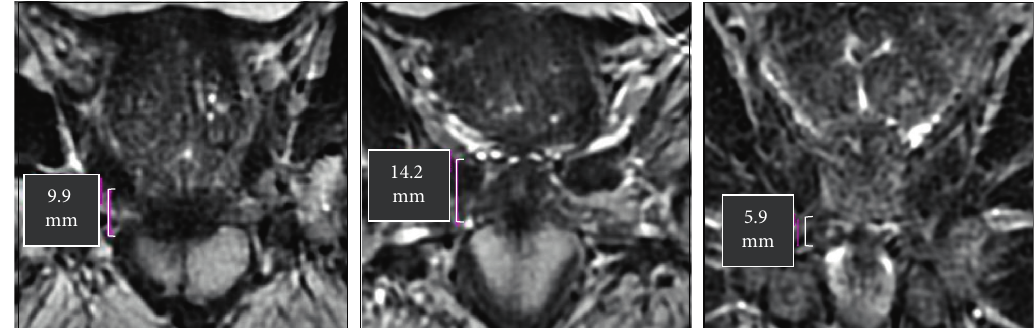
Figure 2: Anatomic variation at the prostate apex. Length of the urogenital diaphragm measured on MRI in the coronal plane is shown.